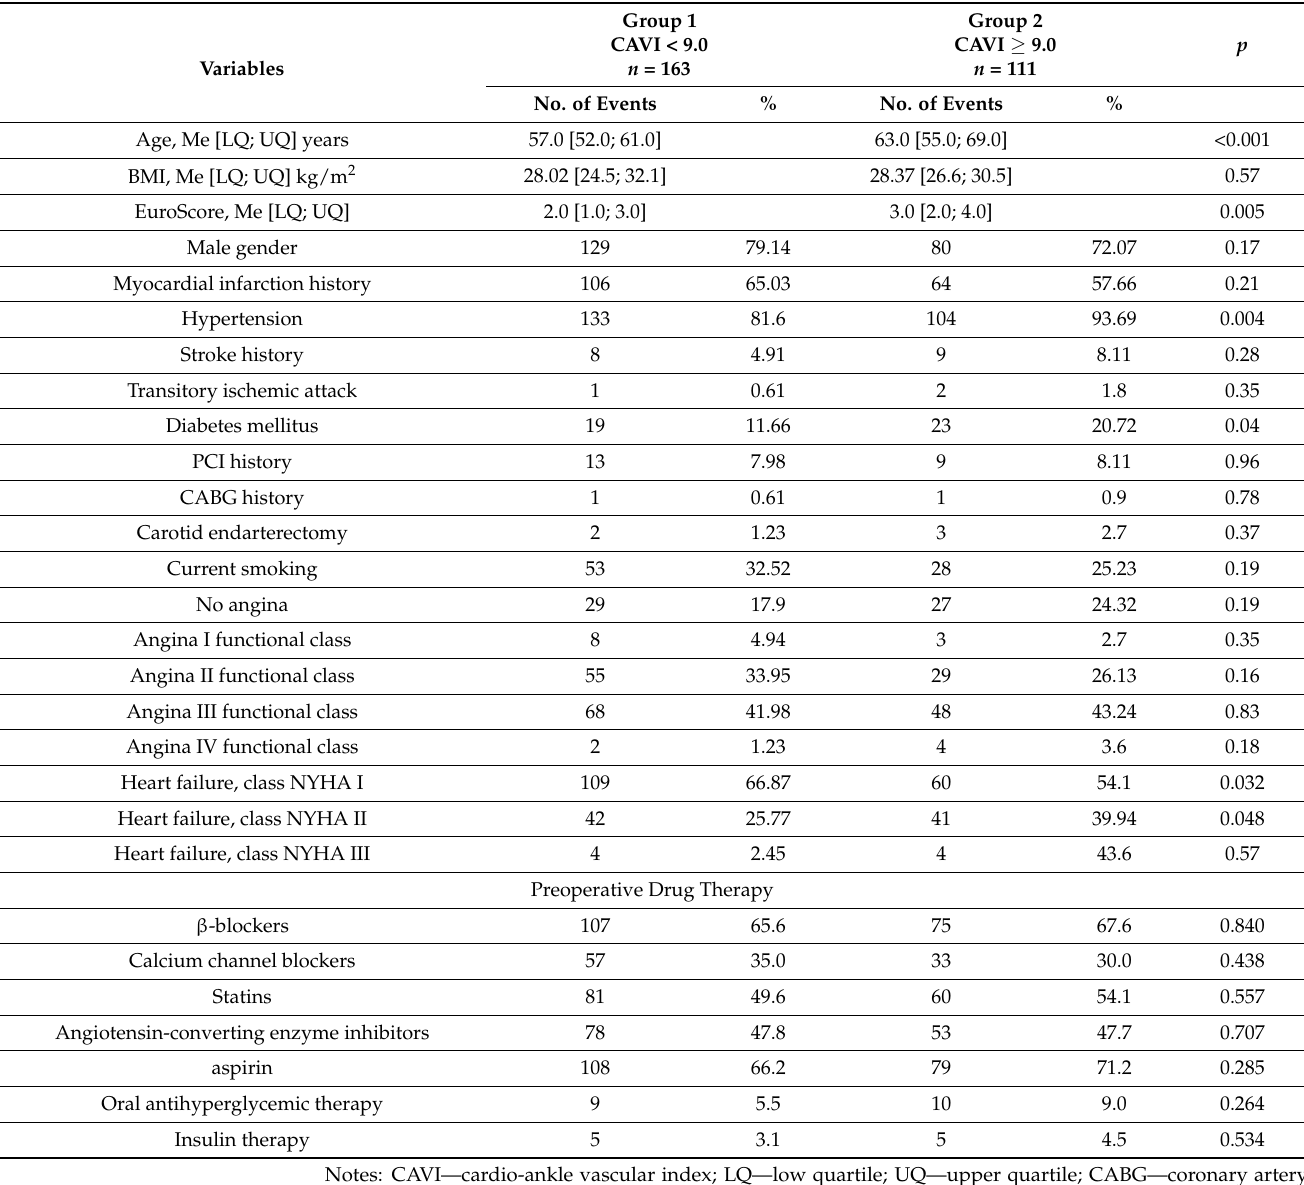
Table 1. Baseline characteristics in groups with pathological and normal CAVI before coronary artery bypass surgery ( n = 274).